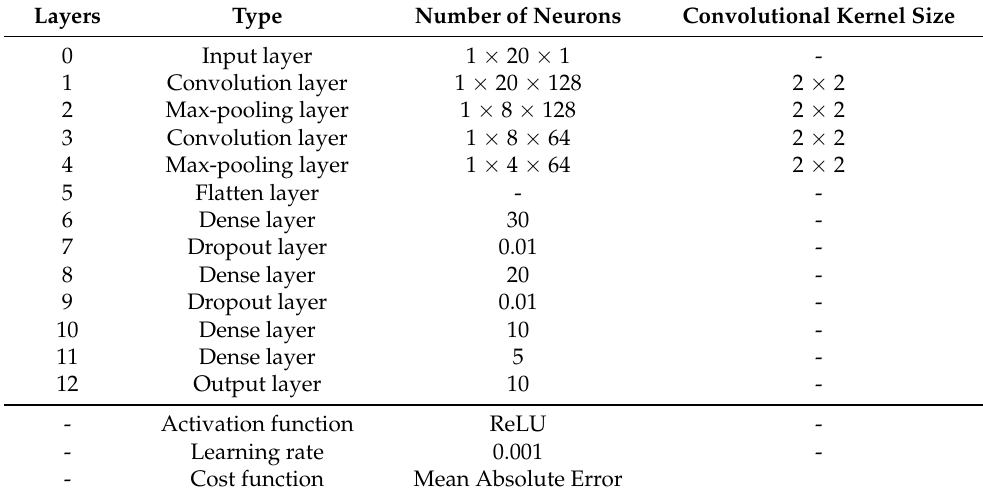
Table 3. DCNN model